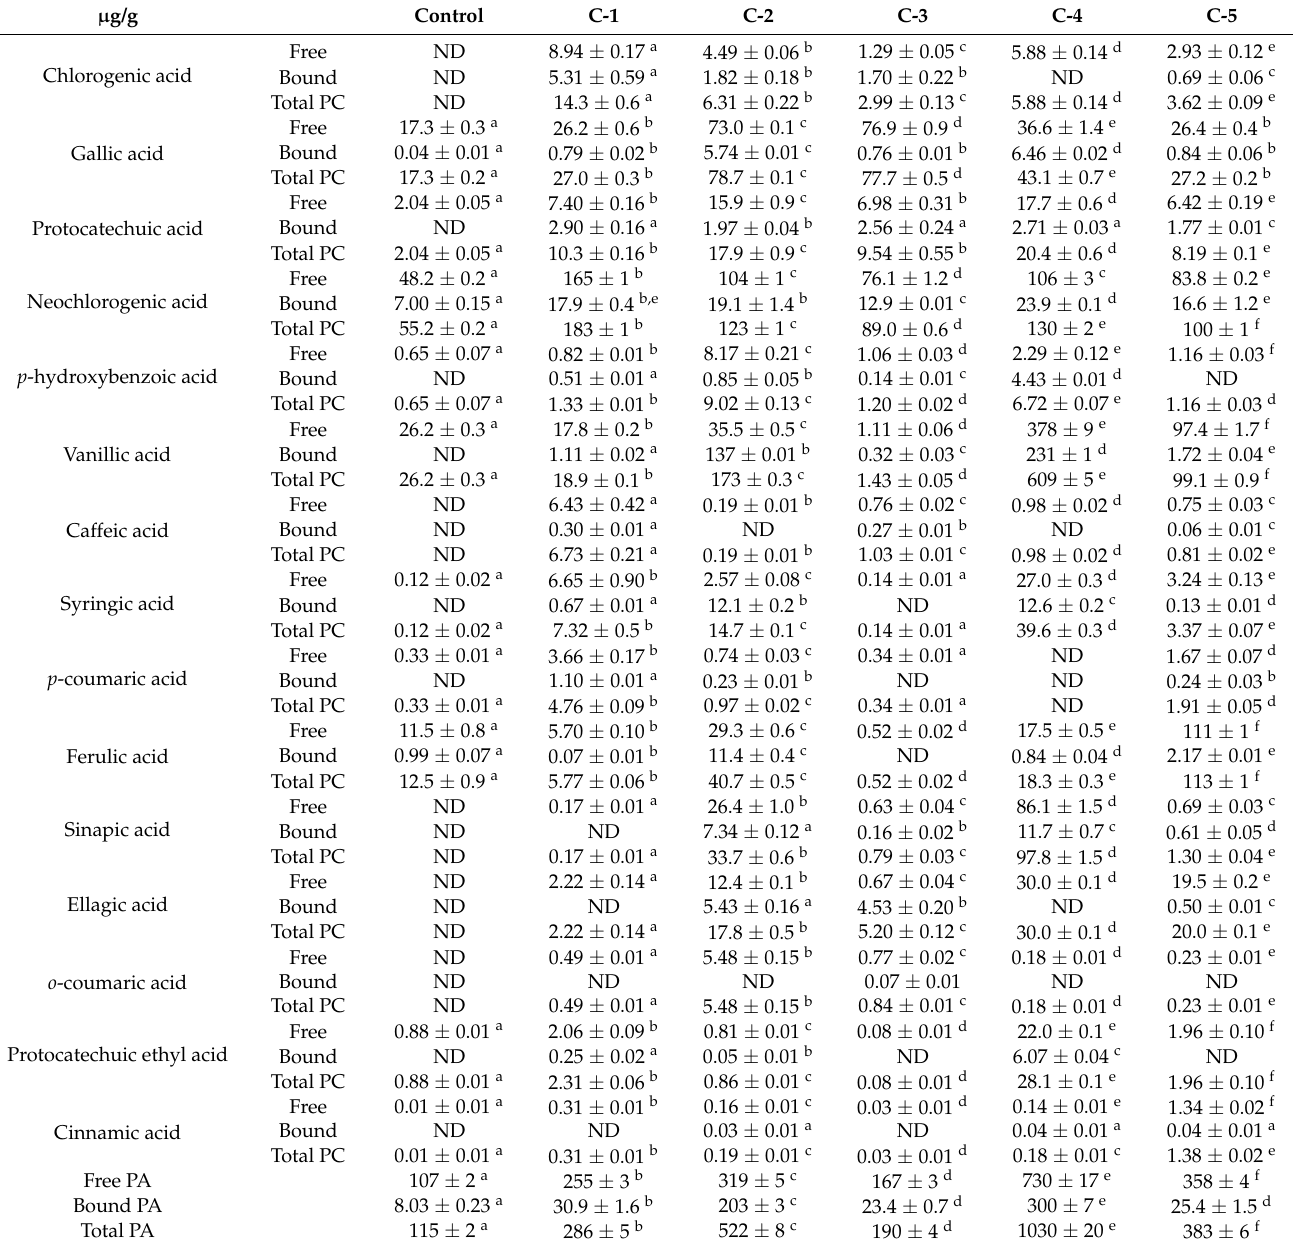
Table 6. Phenolic acid contents of free and bound phenolic compounds extracted from the